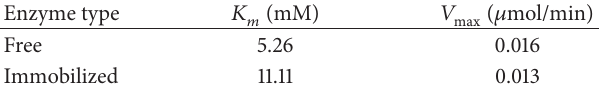
Figure 4: EDX spectrum of the laccase immobilized poly(MMA- co- GMA) cryogel.